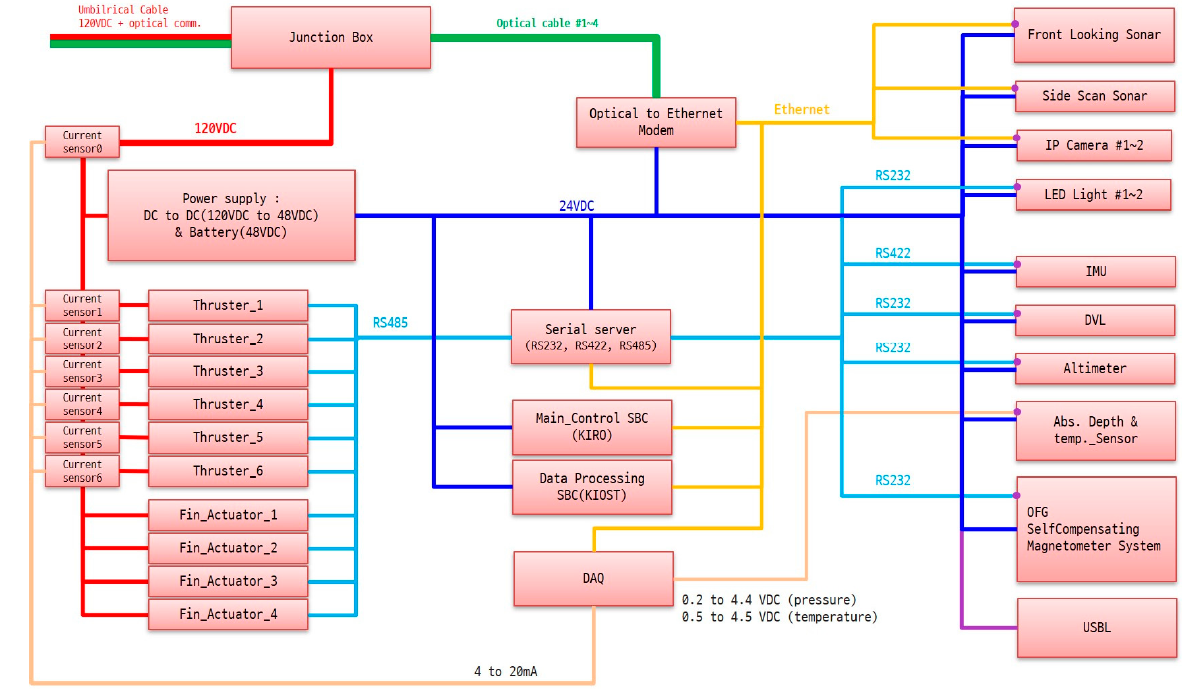
Figure 4. TUP electronic design.